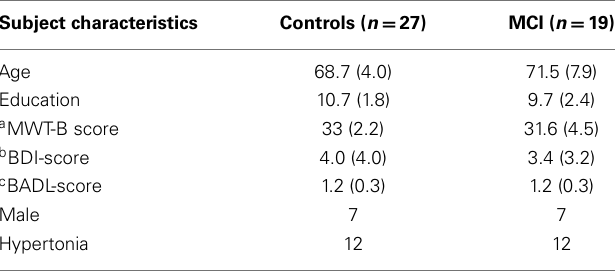
Table 1 | Subject characteristics and neuropsychological test